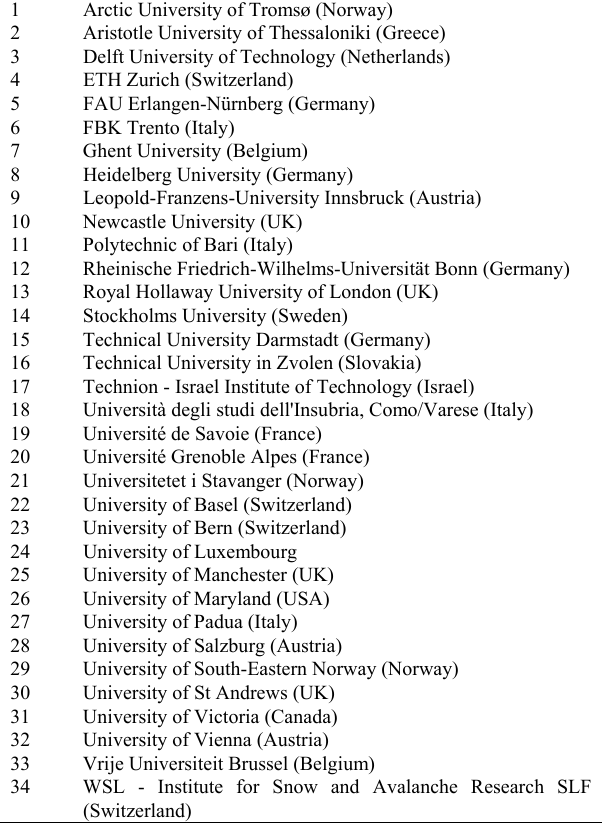
Figure 10. Internationality of participants. Table 3. Affiliations of